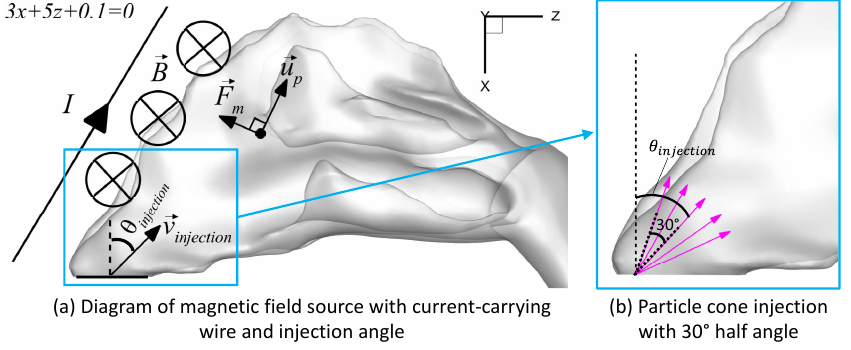
Figure 2. Magnetic field source and spray cone: ( a ) Diagram of magnetic field source with current- carrying wire and injection angle, and ( b ) Velocity vectors of particles injected by a spray